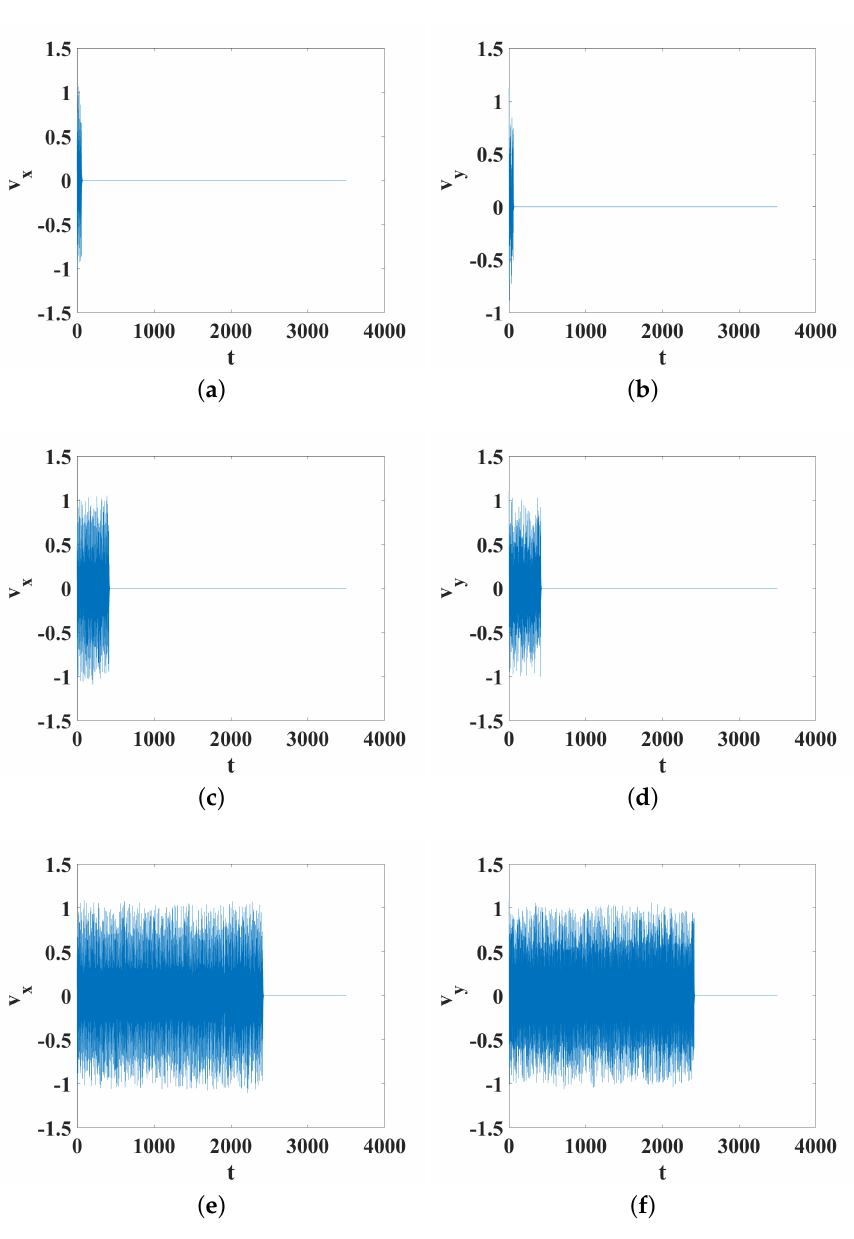
Figure 2. Velocity time evolution for a fixed initial condition and different values of the dispersion medium ( m = 6). ( a , b ) k 2 = 0.6; ( c , d ) k 2 = 0.7; ( e , f ) k 2 =